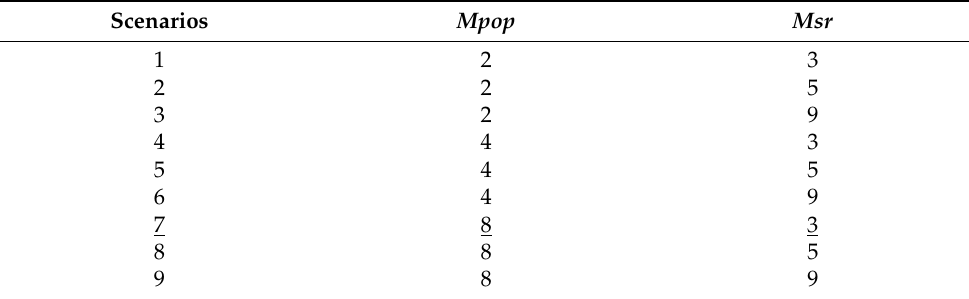
Table 4. Some scenarios of parameters for the water cycle as feature selection.